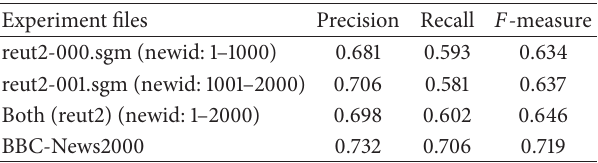
Table 6: Experimental results of GCAS.